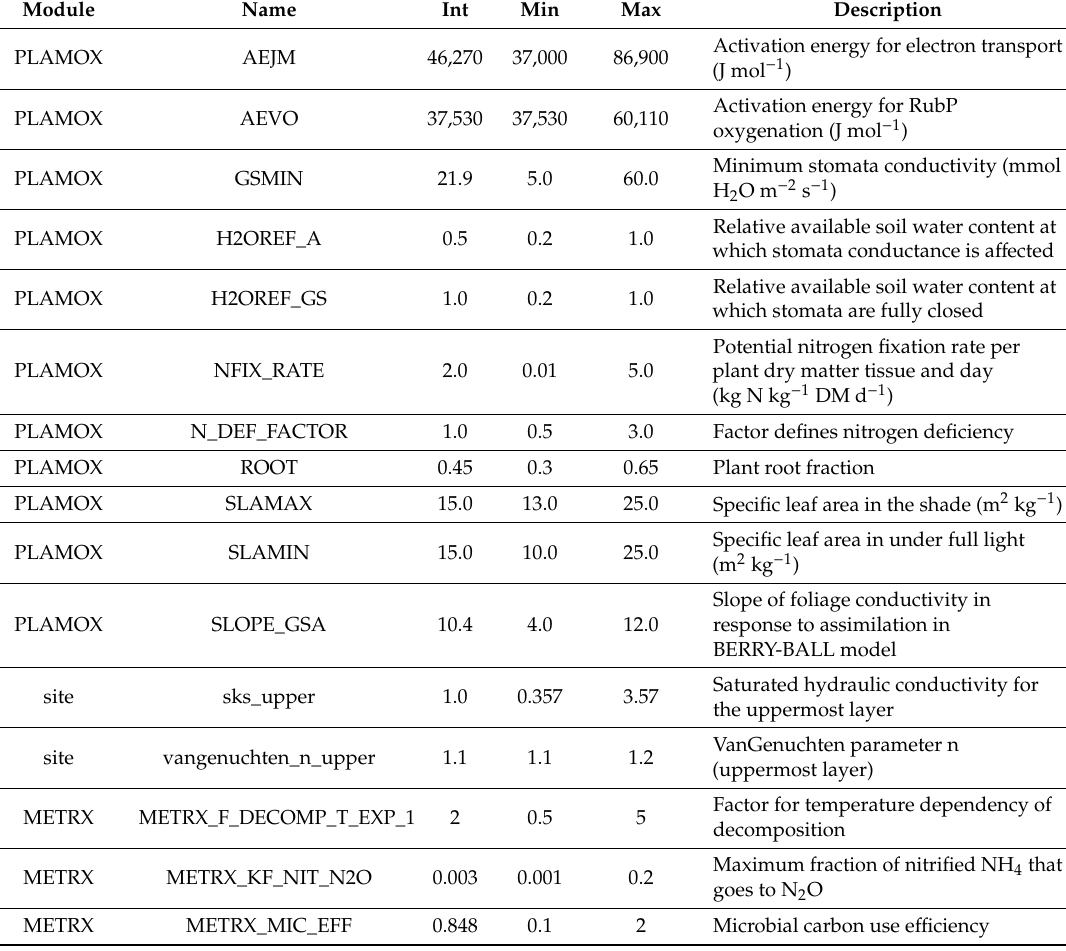
Table A2. Most sensitive LandscapeDNDC parameters. From left: parameters associated module, internal LandscapeDNDC parameter name, initial value, lower and upper limits of the parameter range, process-related description.